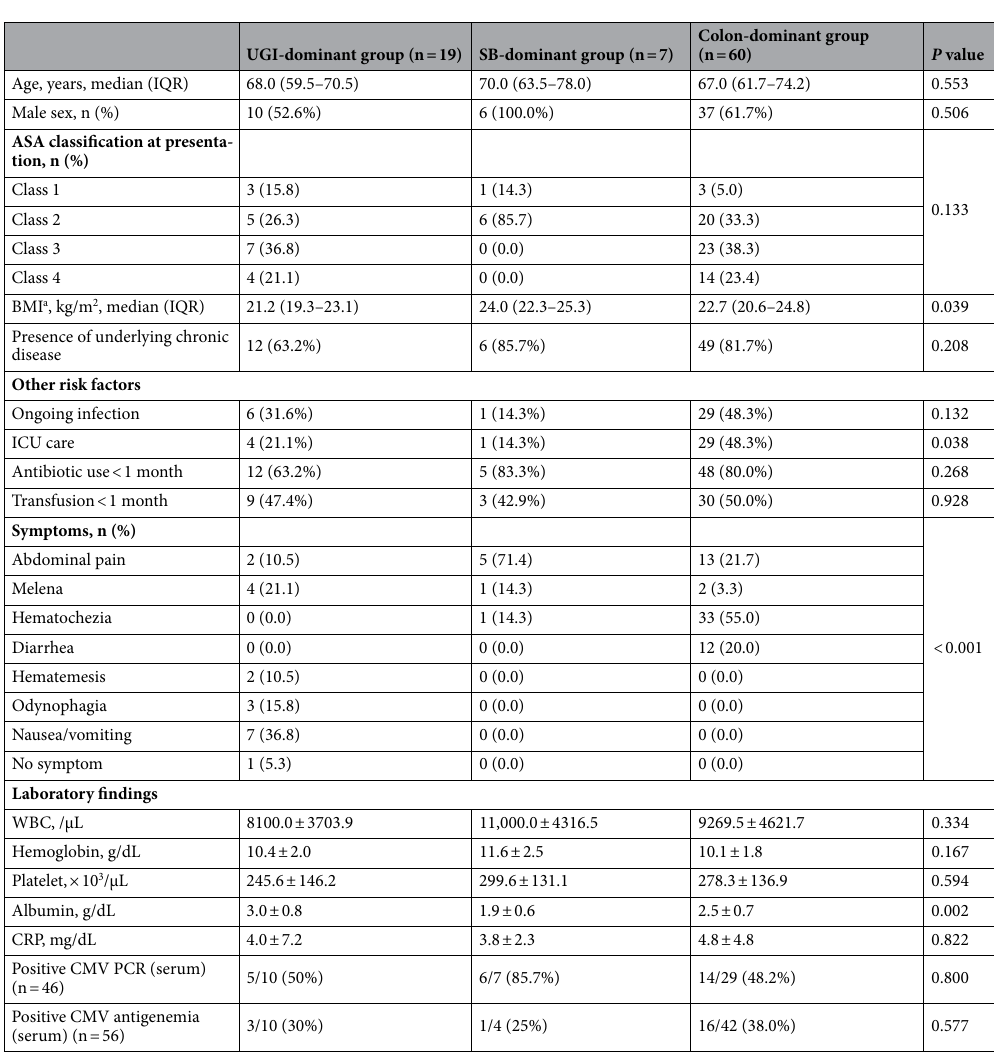
Table 2. Clinical characteristics of cytomegalovirus gastroenterocolitis according to the endoscopic location of involvement. CMV, cytomegalovirus; BMI, body mass index; WBC, white blood cell; CRP, C-reactive protein; PCR, polymerase chain reaction. a Body mass index data were not available for 2 of the 86